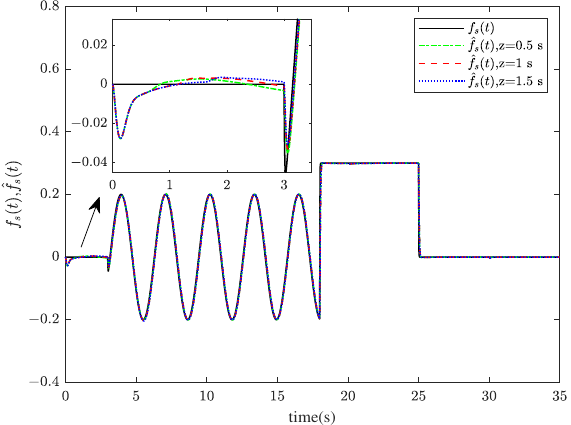
Figure 6. The sensor fault f s ( t ) and its estimation ˆ f s ( t ) .